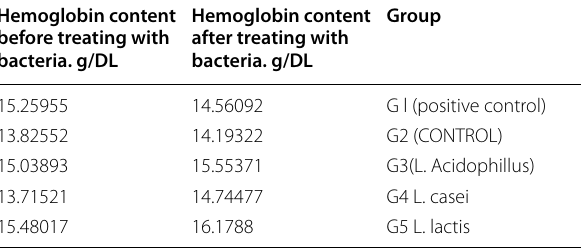
Table 4 Hemoglobin content (g/DL) in mice fed with lactobacillus